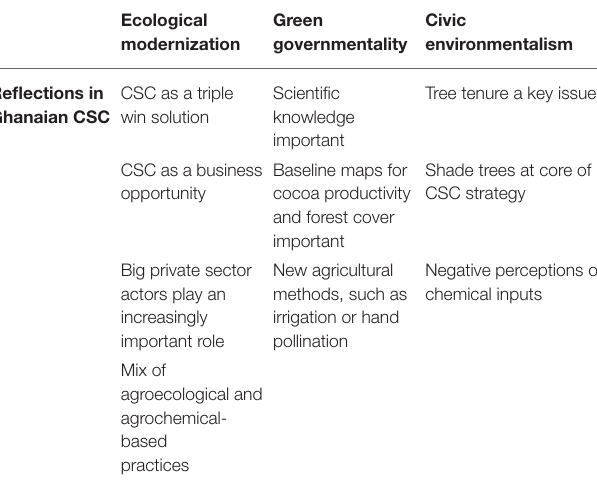
TABLE 3 | Summary of dominant discourses in Ghanaian CSC in accordance with Bäckstrand and Lövbrand (2006) environmental